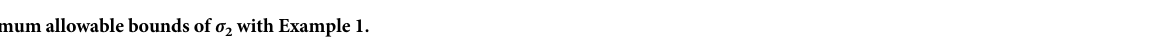
Table 1. The maximum allowable bounds of σ 2 with Example 1. τ d = σ d α =